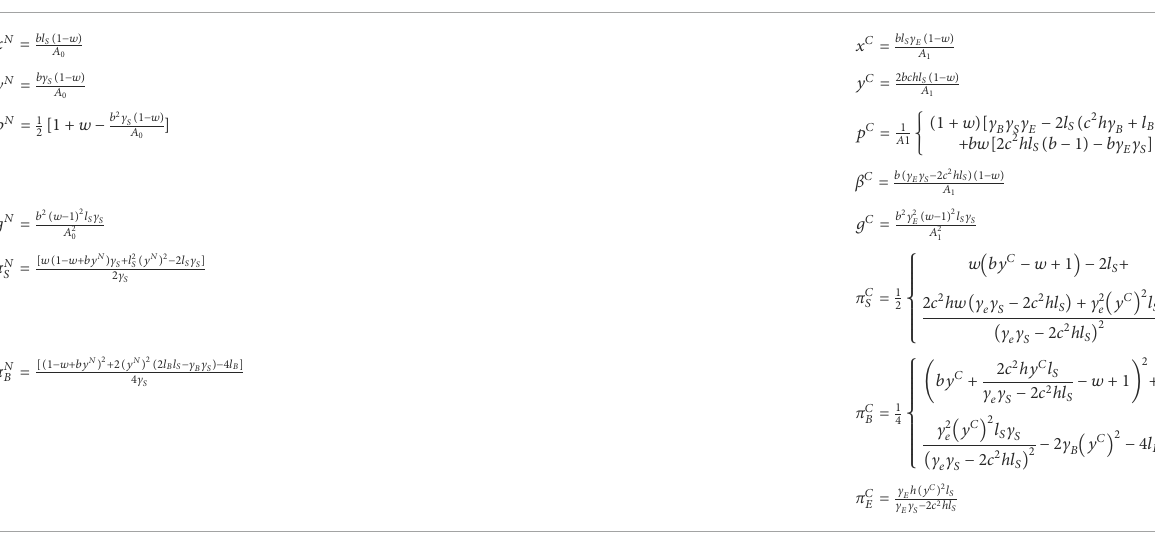
TABLE 4 The equilibrium outcomes in monopoly scenario.